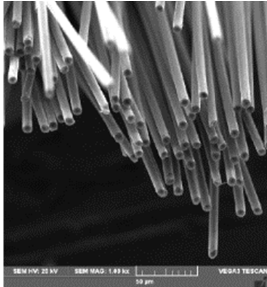
Figure 7. Rotating roll sort operation of carbon fiber. After adjusting the moving direction of the carbon fiber, gas is injected and power is supplied to coat the carbon in a dry manner. The vacuum pressure used here started argon injection at 7 × 10 − 5 torr, purged for 10 min, and generated plasma in the 9 × 10 − 3 torr band. The voltage was 800 VDC and the power was 2.8 kW. Figure 8 is an SEM picture of the coated carbon fiber with the speed set to 10 cm/min.